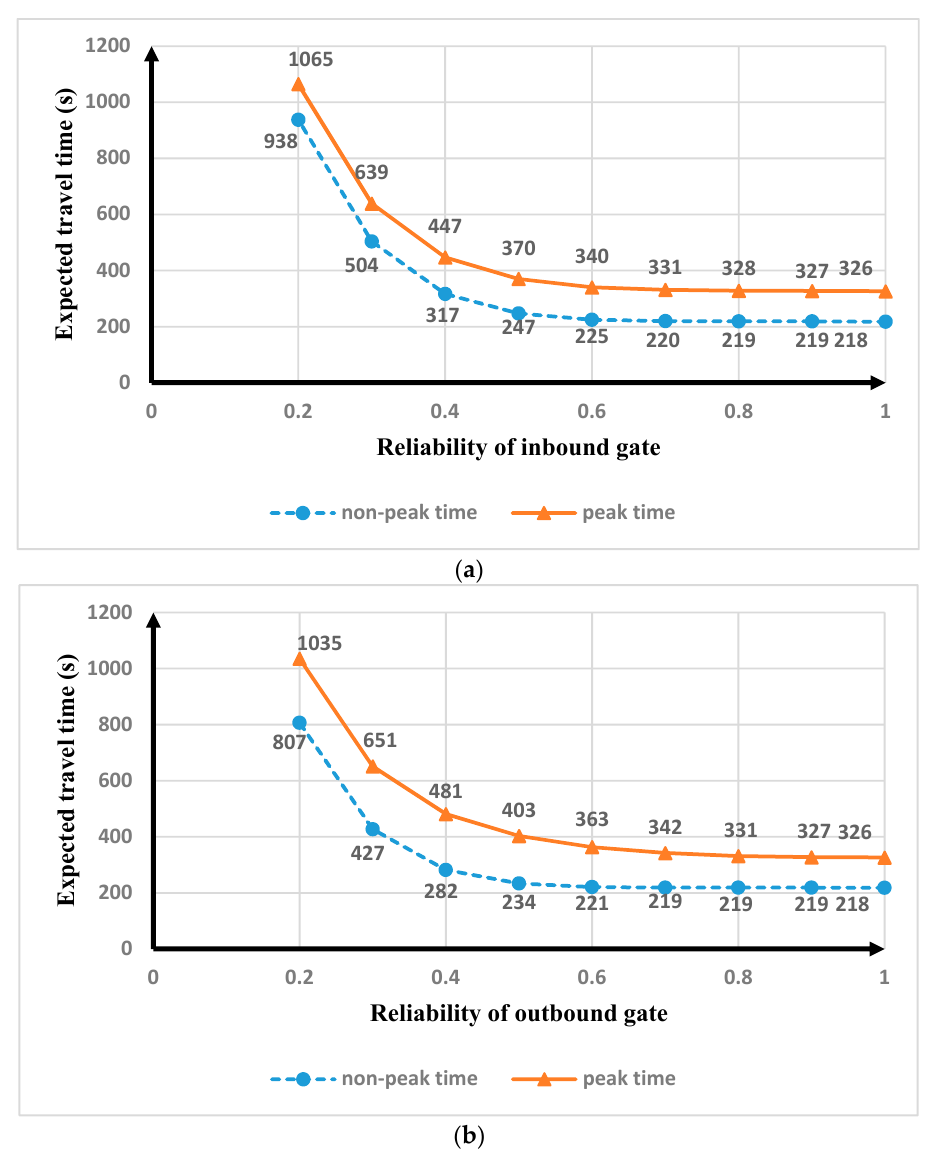
Figure 10. The impact of the reliability of the gate on expected travel time. ( a ) The impact of the reliability of the inbound gate on expected travel time; ( b ) The impact of the reliability of the outbound gate on expected travel time.